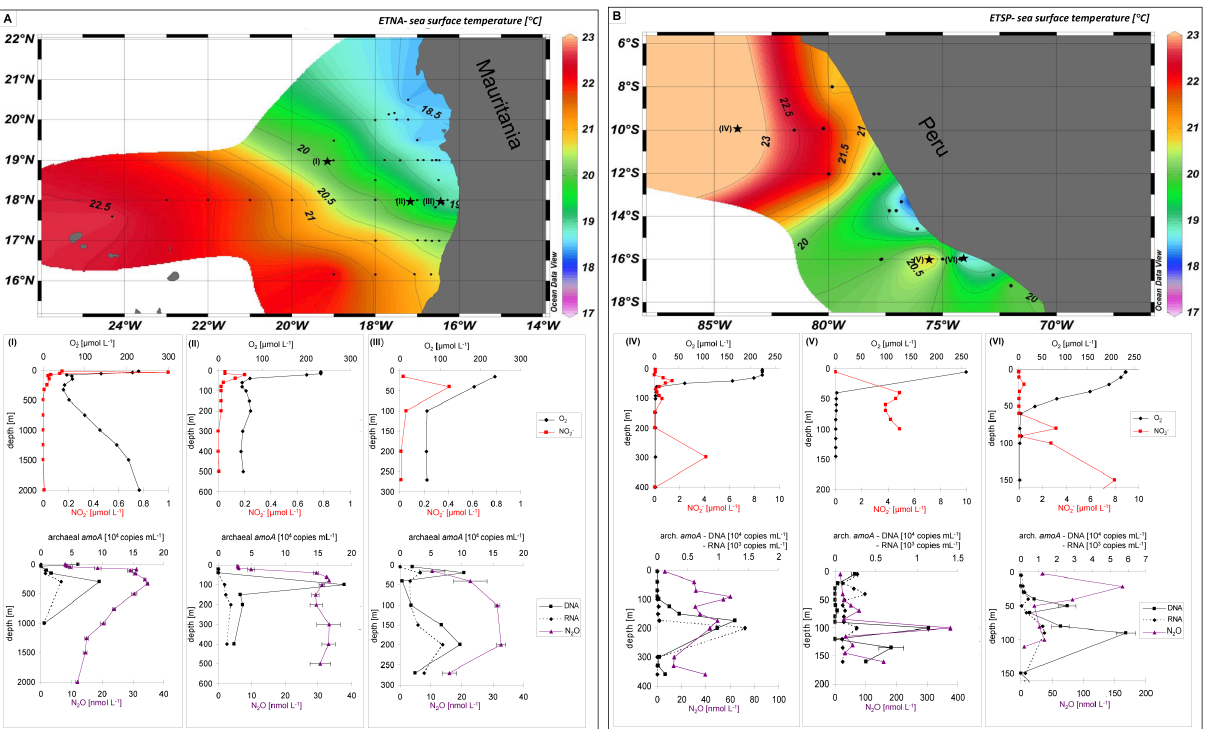
Fig. 1. Maps of sea surface temperatures (A) from the eastern tropical North Atlantic Ocean and (B) from the eastern tropical South Pacific Ocean. The locations of sampling stations are indicated with asterisks in the maps. Selected vertical profiles (I–VI) of O 2 , NO − (measured in triplicates) and archaeal amoA (measured in duplicates by qPCR) are shown; (I) and (IV) are located offshore, (II) and (V) are located on the continental slope, and (III) and (VI) are onshore/coastal